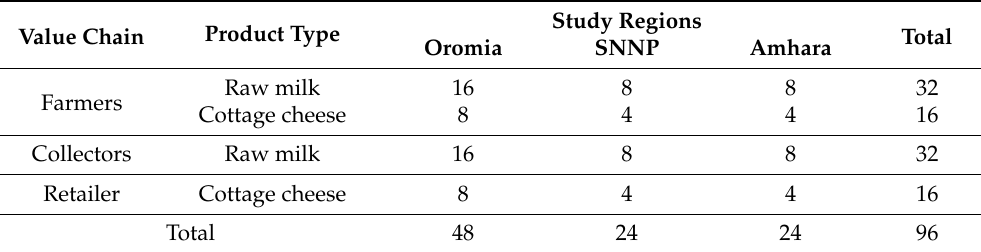
Table 1. Composite sample size of milk products along the value chain in